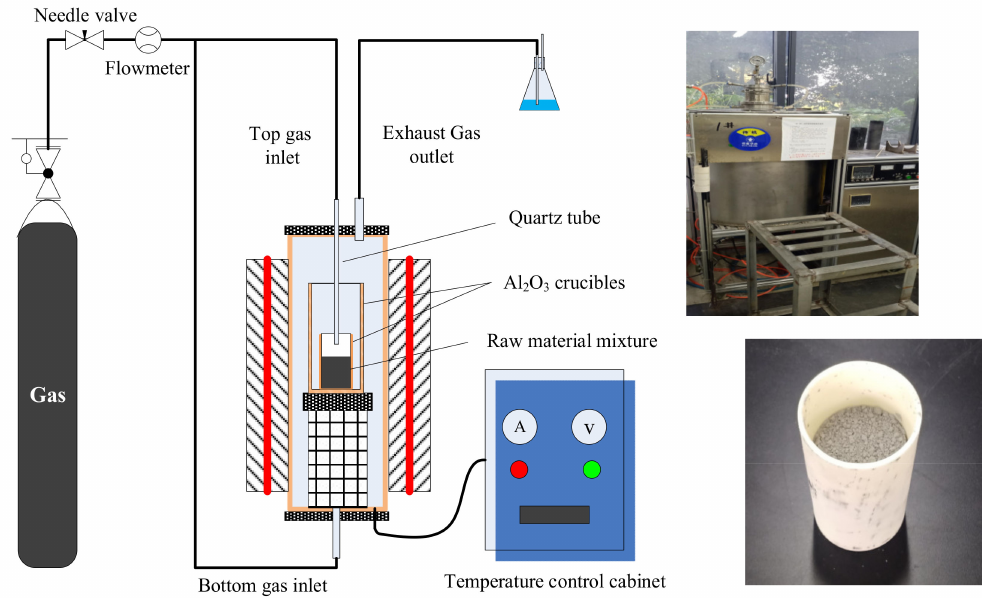
Figure 7. Schematic diagram and physical diagram of the experimental